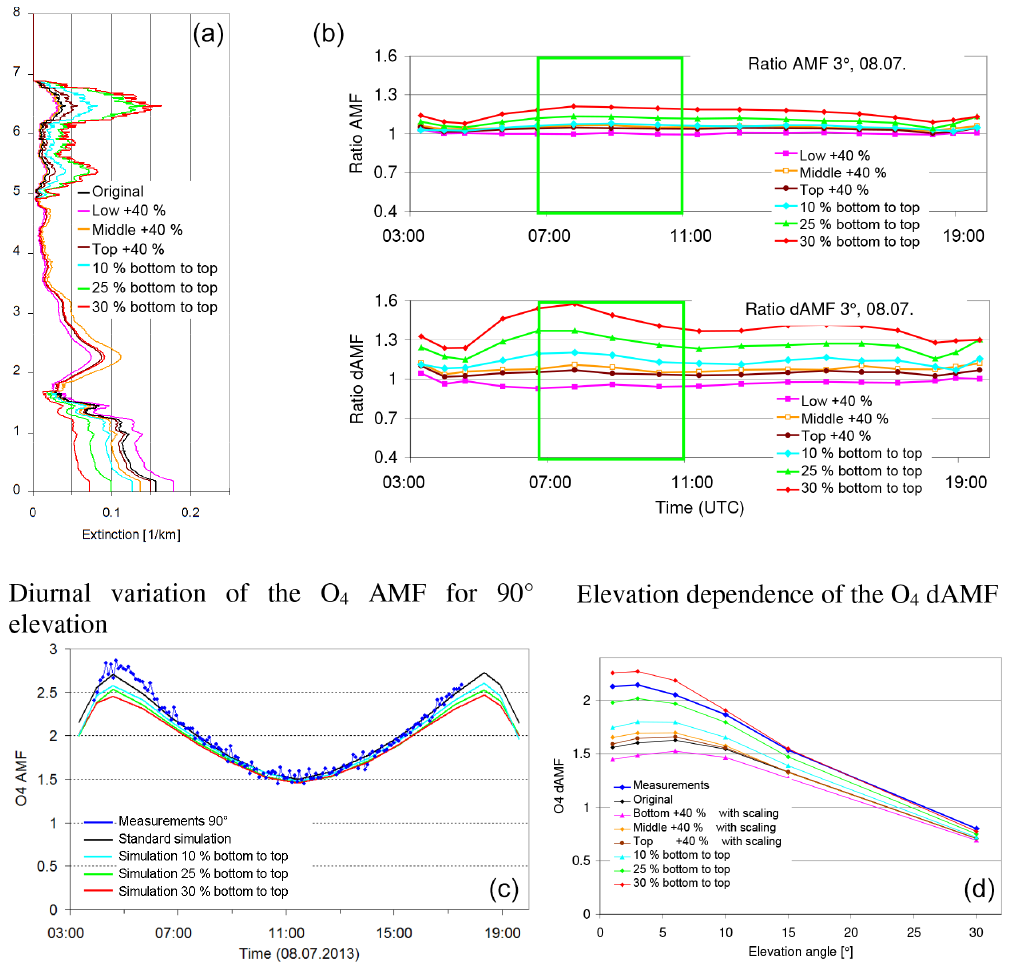
Figure A34. (a) Aerosol profiles used for the simulations (see text). (b) Ratios of the O 4 (d)AMFs simulated for the modified profiles vs. those of the original profile. (c, d) Comparison of the measured diurnal variation (SZA dependence) for 90 ◦ elevation (c) and the elevation dependence of the O 4 dAMFs for the period 07:00–11:00 on 8 July (d) .